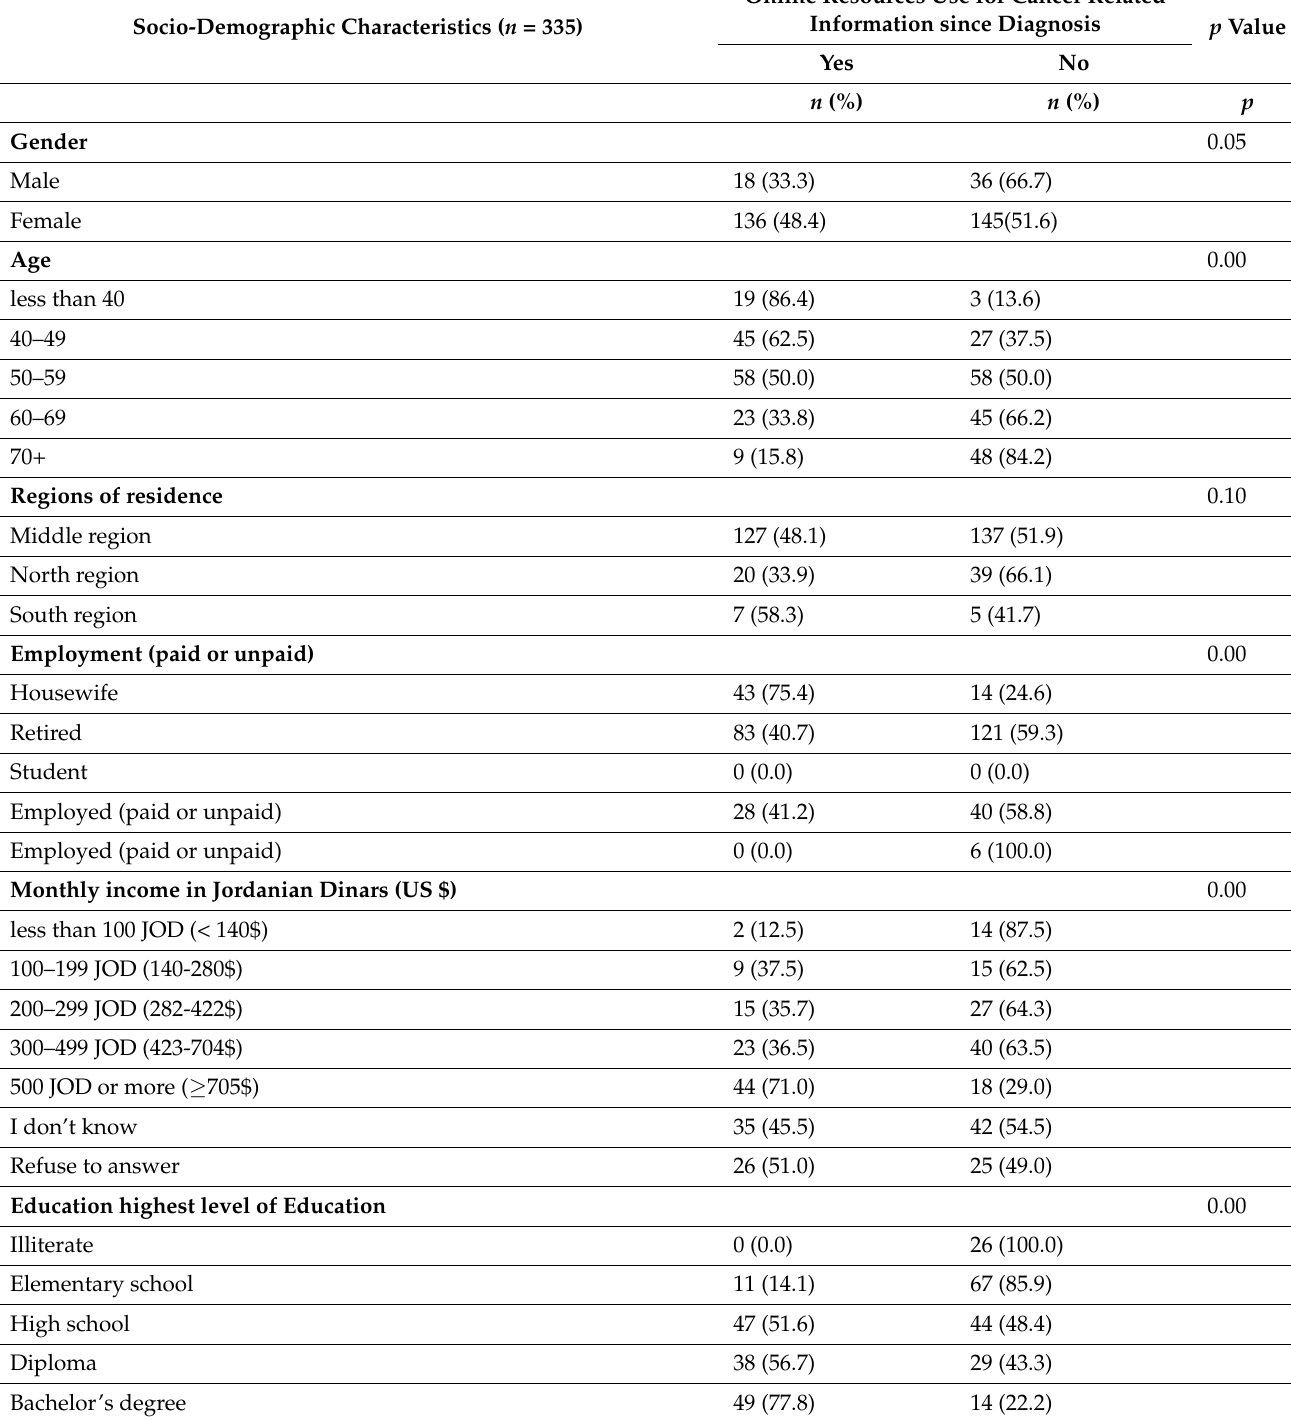
Table 2. Patient demographics stratified by online seeking behavior n =